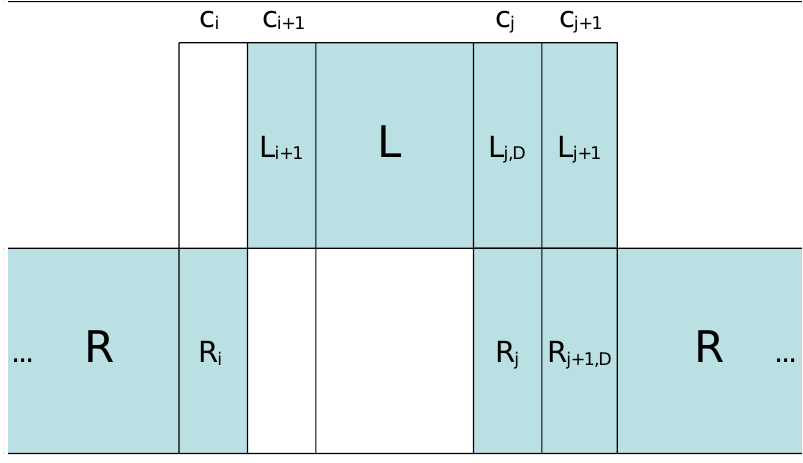
Figure 7 . Factorization limits apply both patterns of positive components.